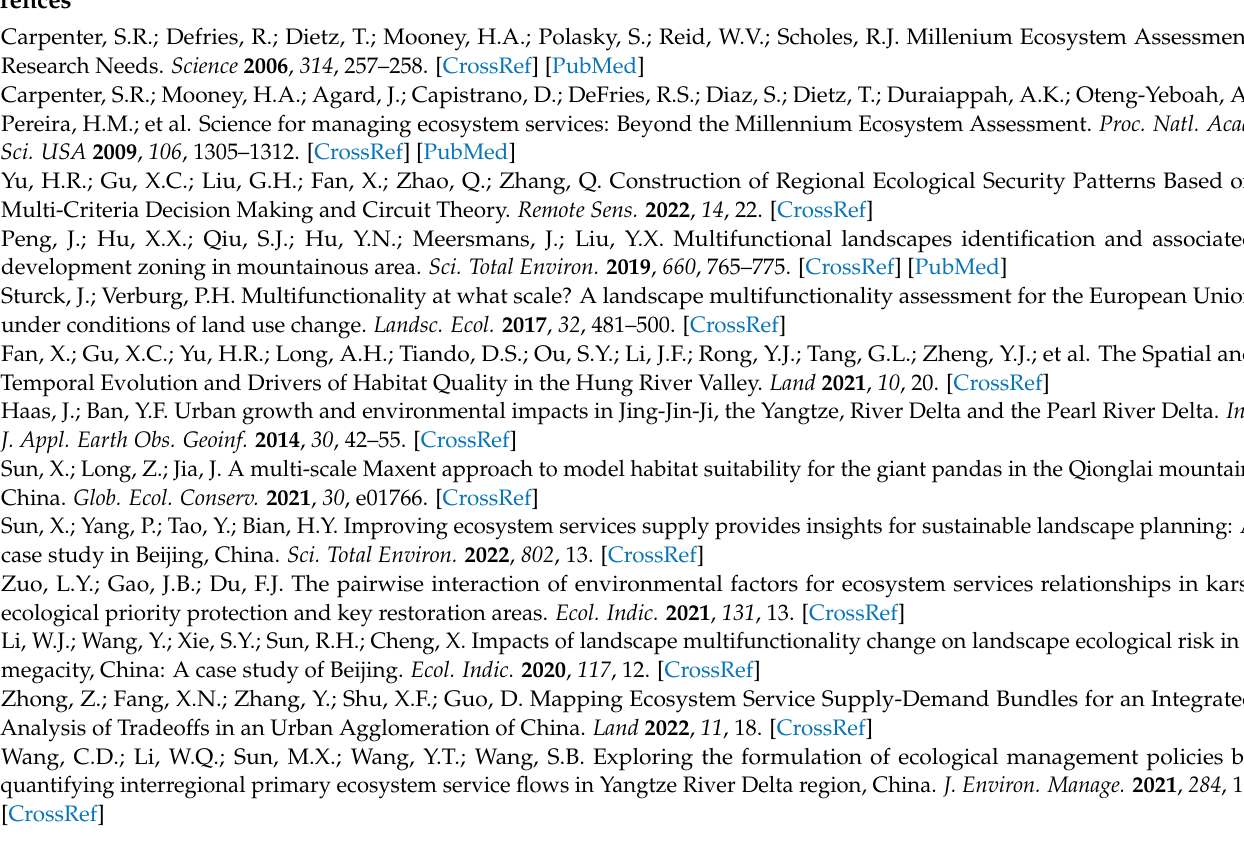
Figure A2. Spatial distribution of topographic potential index in the Yang tz e River Delta.